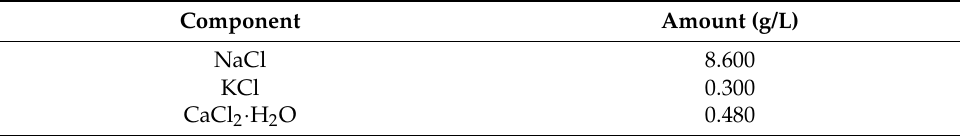
Table 2. Composition of the Ringer’s